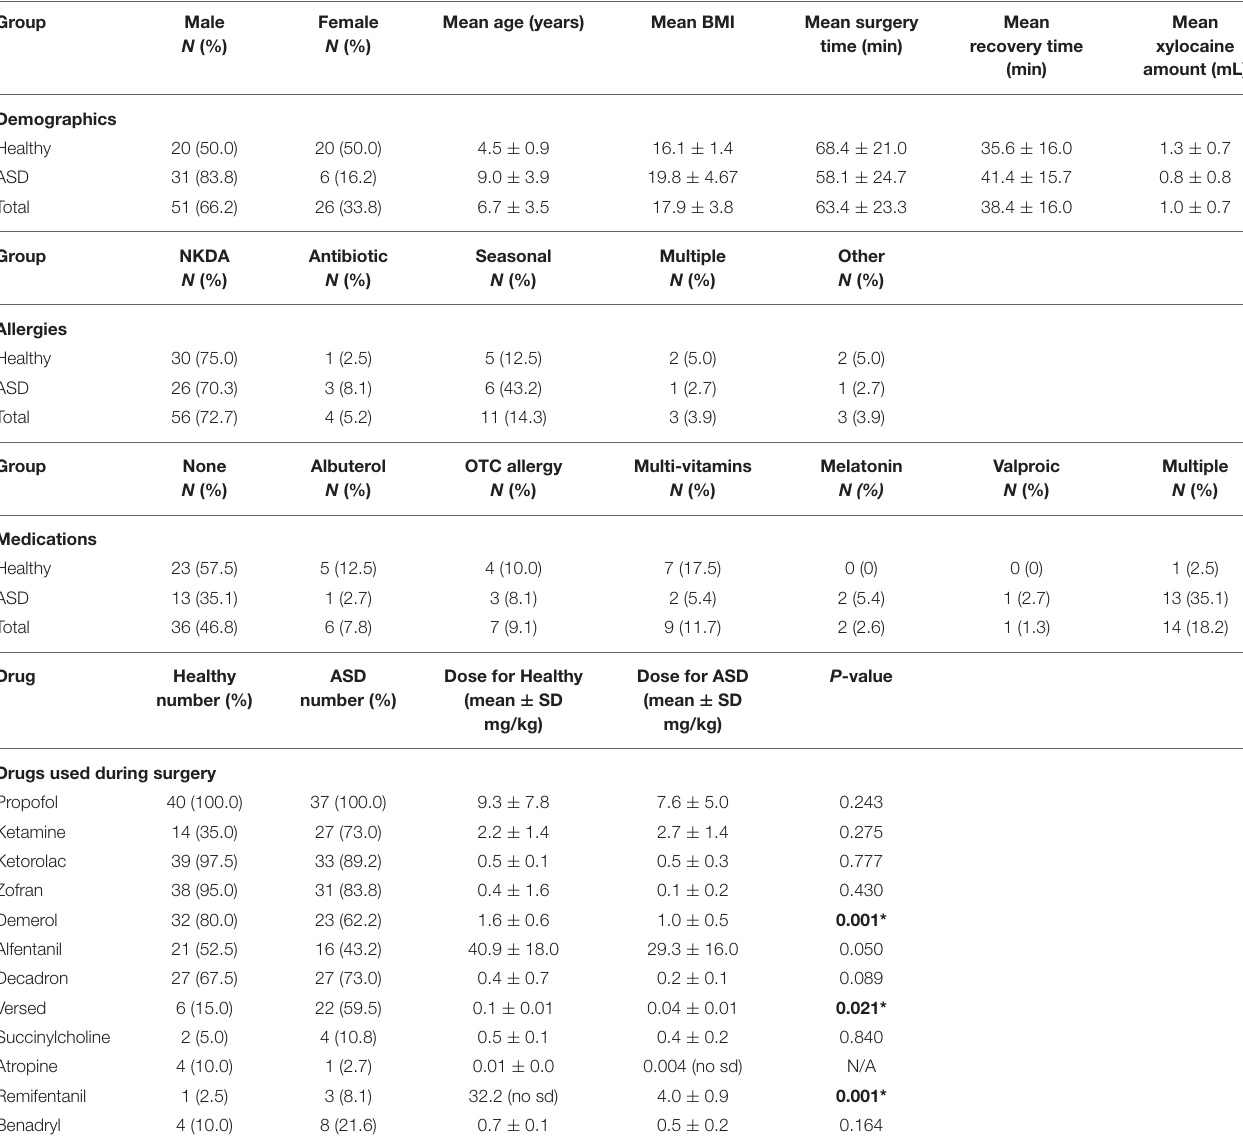
TABLE 1 | Demographic data